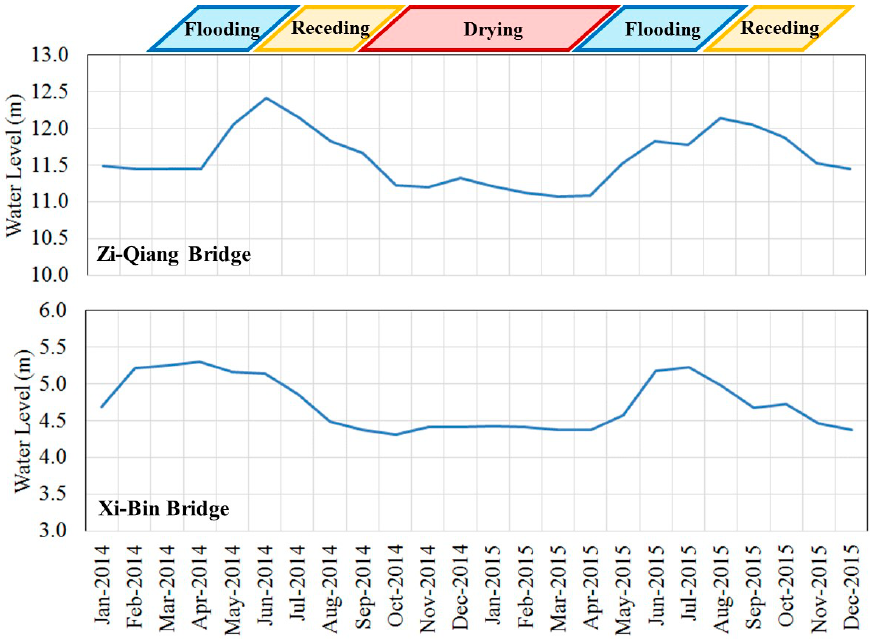
Figure 2. The seasonal variations of water level at Zi-Qiang Bridge and Xi-Bin Bridge.